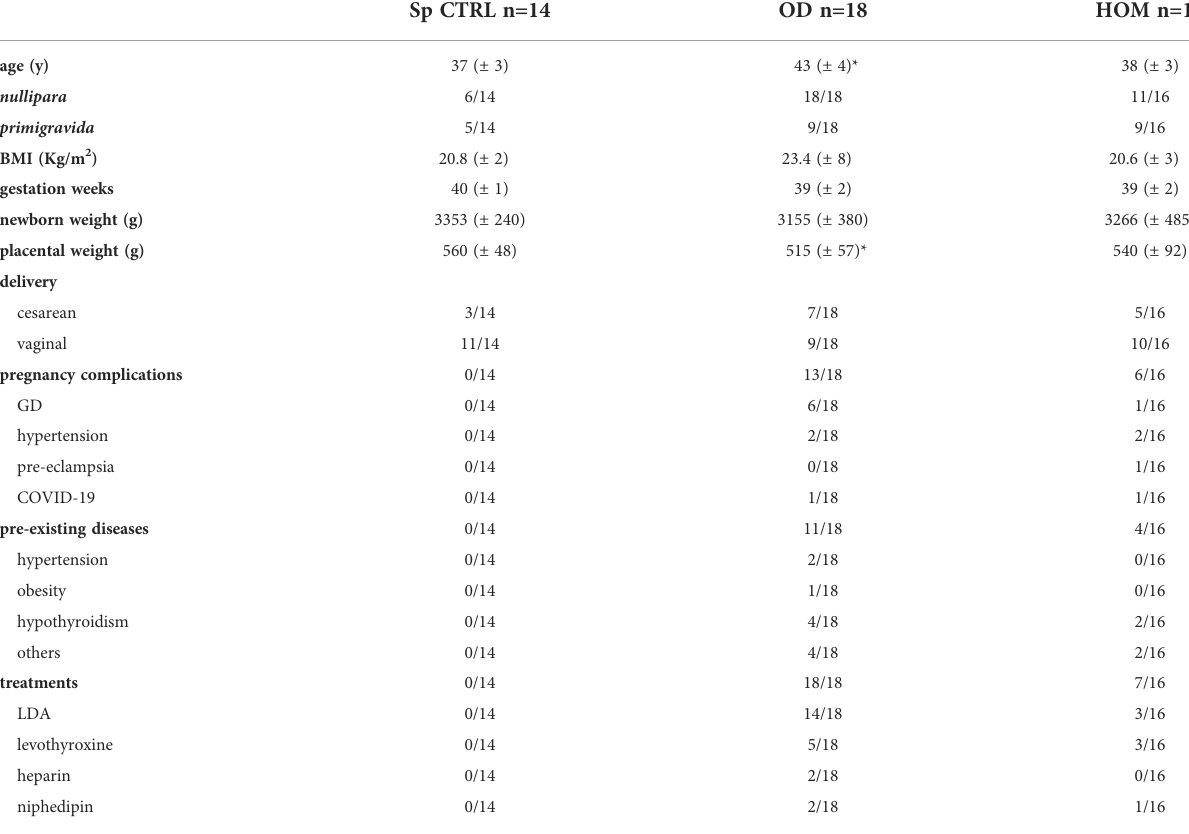
TABLE 1 Characteristics of the ART patients ’